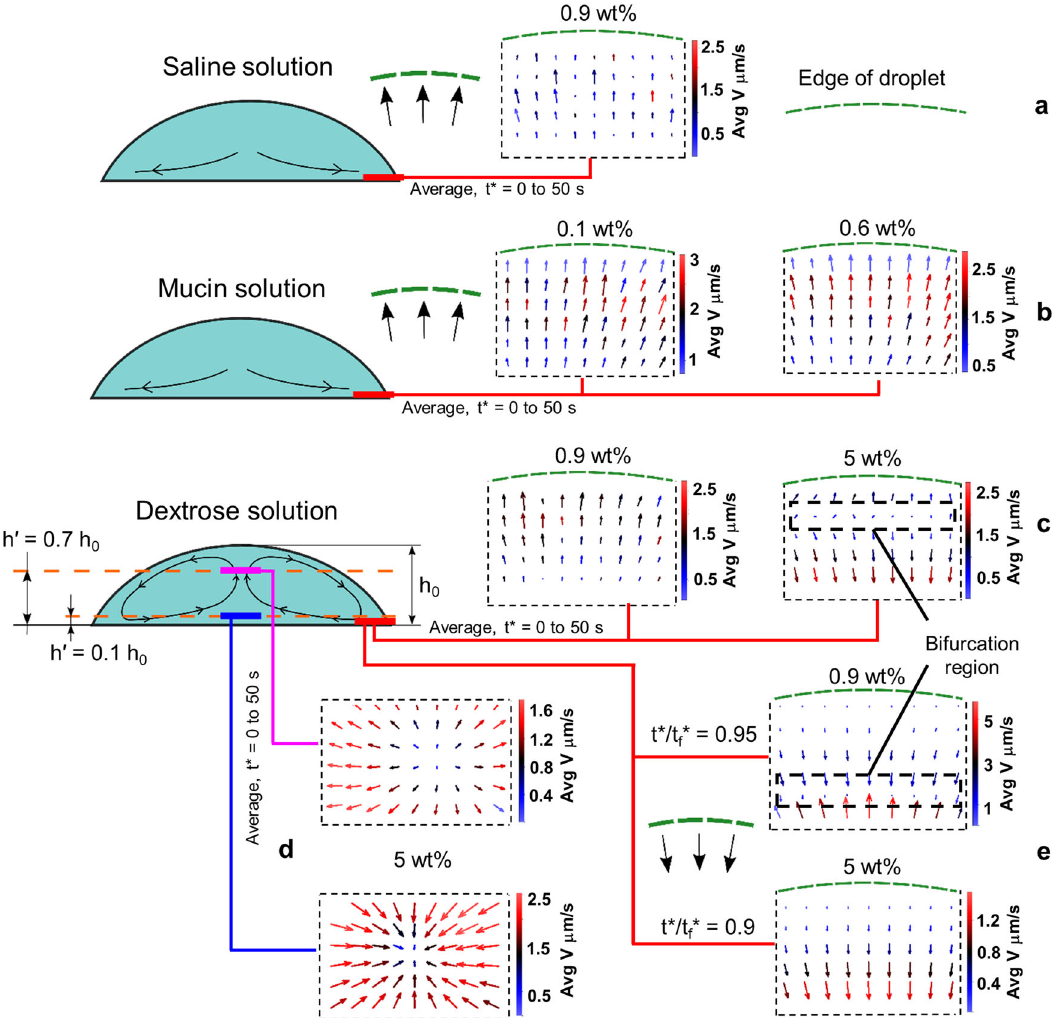
Fig. 4 Flow visualization for saline, mucin, and dextrose medium droplets. a Vector plot (averaged over the fi rst 50 s) depicting capillary fl ow at the edge for a droplet of saline solution. b Vector plot (averaged over the fi rst 50 s) depicting capillary fl ow at the edge for droplets of mucin 0.6 wt% and 0.1 wt% solutions. c Vector plot (averaged over the fi rst 50 s) depicting weak solutal marangoni for dextrose 0.9 wt% and strong solutal marangoni for dextrose 5 wt% at the edge. d Vector plots (averaged over the fi rst 50 s) depicting marangoni fl ow for dextrose 5 wt% at two different heights ( h 0 = 0.1 and 0.7) in the center of the droplet. e Receding fl ow due to marangoni at the fi nal stages of evaporation for dextrose 0.9 wt% and 5 wt%. t * is the elapsed time. t f is the fi nal time of evaporation.